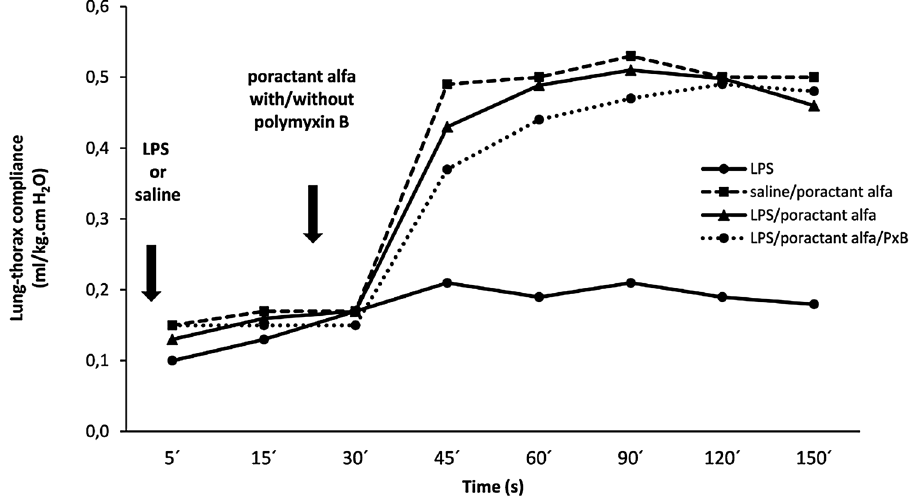
Figure 4. Lung-thorax compliance during the experiment in preterm newborn rabbits exposed to LPS (negative control) or saline (positive control) at delivery and treated with poractant alfa with or without PxB at 30 min of ventilation. Statistical analysis: at all time points since 45th min, all groups > LPS; P < 0.001; at 45th min, LPS/poractant alfa/PxB < saline/poracant alfa, P <